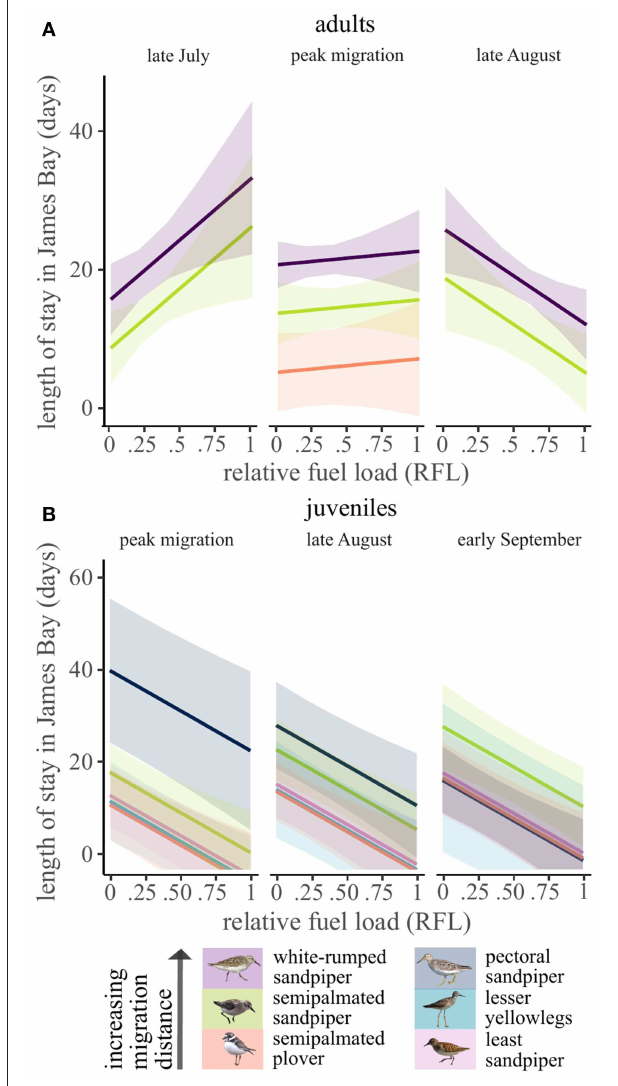
FIGURE 2 | Model predicted patterns in minimum length of stay of (A) adult and (B) juvenile shorebirds along the southwestern coast of James Bay, Ontario, Canada in 2014–2017. Predictions were made at different time periods to demonstrate interactions between day of year by relative fuel load at capture (adults) and day of year and species (juveniles). Late July predictions were made at day of year 205 (corresponding to early arrival adults), peak migration at day 220 (most adults and early juveniles), late August at day 235 (late adult captures, most juveniles), and early September at day 250 (late juvenile captures). Semipalmated plover adults were only captured during the peak migration